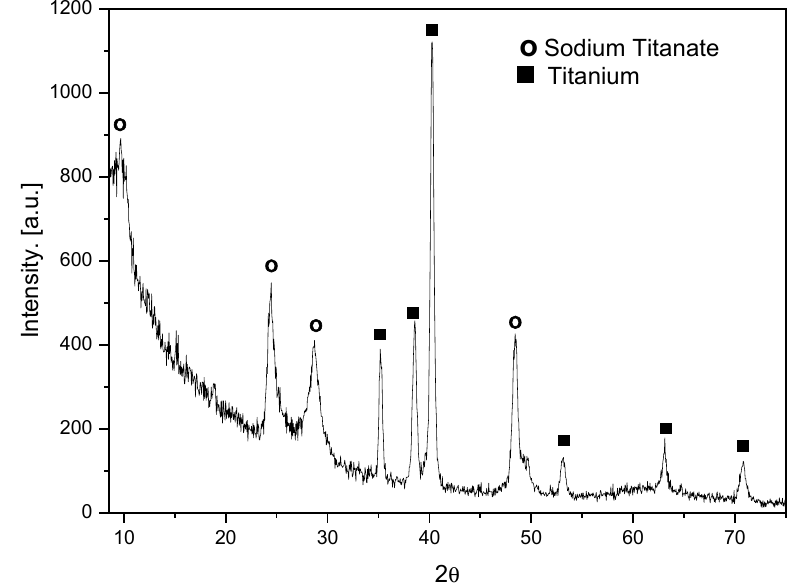
Figure 2. GIXRD diffractogram of Ti surface after hydrothermal treatment Figure 2. GIXRD di ff ractogram of Ti surface after hydrothermal treatment (TTNT).